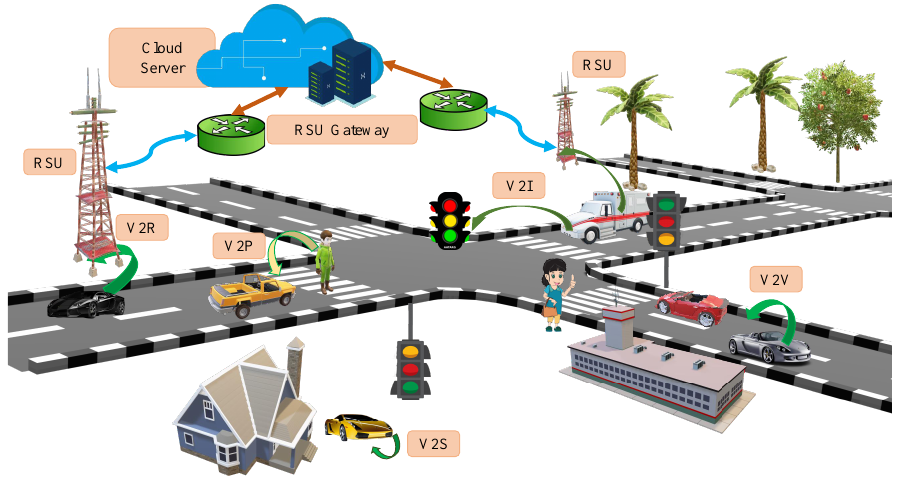
Figure 1. Internet of Vehicle (IoV) connectivity.